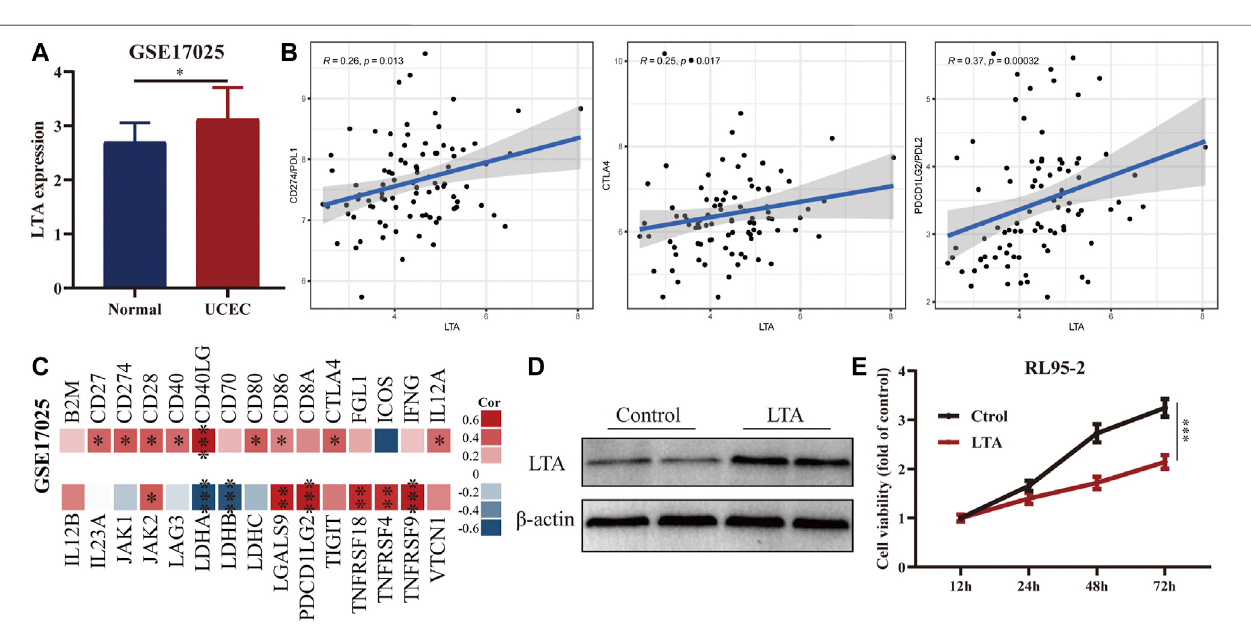
FIGURE 7 | Exploration of the differential expression of LTA in normal and early UCEC patients (A) and its correlation with common immune markers (B,C) using GSE17025 data. Immunoblotting (D) and CCK8 (E) analyses of LTA overexpressed in RL95-2 cells (* p < 0.05, ** p < 0.01, *** p < 0.001).